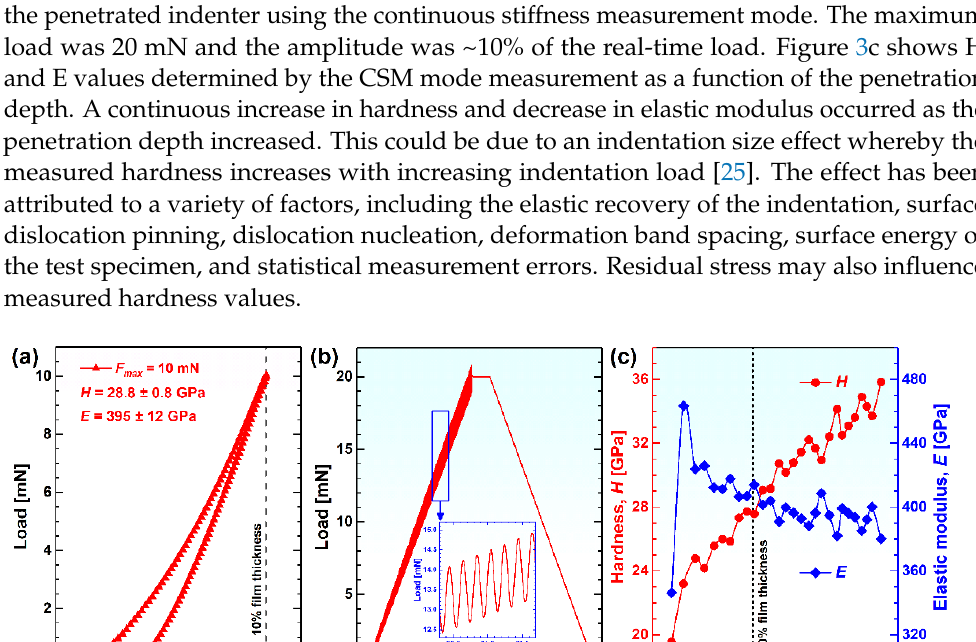
Figure 3a exhibits load-penetration depth curves of nanoindentation tests (constant load mode, max. load 10 mN) applied on the film surface. The maximum penetration